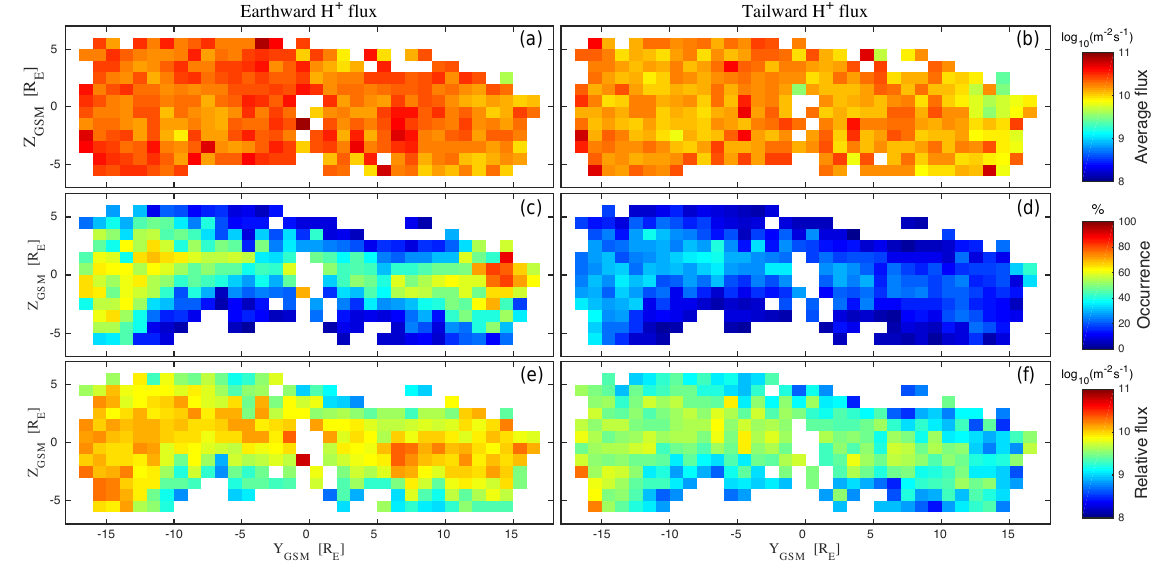
Figure 2. The spatial distributions (given in R 2 square bins) projected to the YZ | GSM for earthward (a, c, e) and tailward (b, d, f) central E plasma sheet H + fluxes. (a, b) Average local fluxes; (c, d) occurrence rates; (e, f) the time-average fluxes obtained by multiplying the average flux by the occurrence frequency bin by bin.